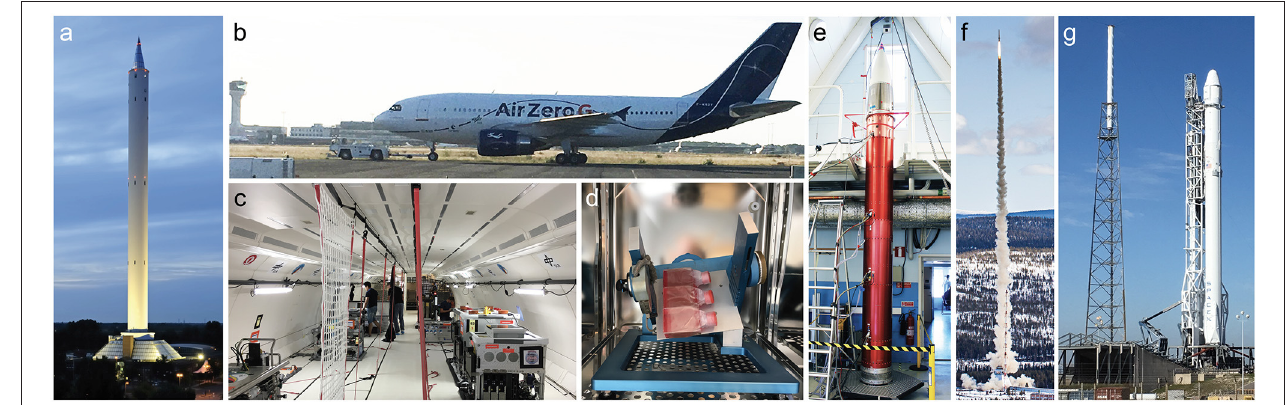
FIGURE 1 | Images of platforms for research experiments in real and simulated microgravity conditions. (a) ZARM Drop Tower, Bremen Germany. Ground-based facility providing installation of the experimental set up in an airtight capsule which is released in a tube inside the tower. High payload masses and up to 10s of real microgravity can be provided (credit ZARM Drop Tower Operation and Service Company). (b) Airbus A310 AirZeroG parabolic aircraft operated by Novespace, Bordeaux, France. Repeated periods of ∼ 22s of real microgravity can be obtained during parabolic flight maneuvers. (c) Experimental area inside the AirZeroG aircraft with different experiment racks. An enormous advantage of parabolic flights is that experimenters have the opportunity to access hardware during microgravity exposure. (d) Desktop Random Positioning Machine invented and constructed by Airbus, Defense, and Space, Leiden, NL. This ground-based instrument accommodates large sample sizes and the samples are rotated around two axes in order generated multidirectional g -force thereby canceling the cumulative gravity vector at the center of the device. (e) Payload of a TEXUS-type sounding rocket (SSC, ESRANGE, Kiruna, Sweden). (f) Launch of a TEXUS-51 sounding rocket from SSC, ESRANGE, Kiruna, Sweden, which empowers microgravity for ∼ 6min. (g) SpaceX CRS-8 rocket on the launch pad, Kennedy Space Center (KFC), FL, USA providing resupply and experiments to ISS. Currently, the ISS is the only option that provides long-time exposure to microgravity (months or